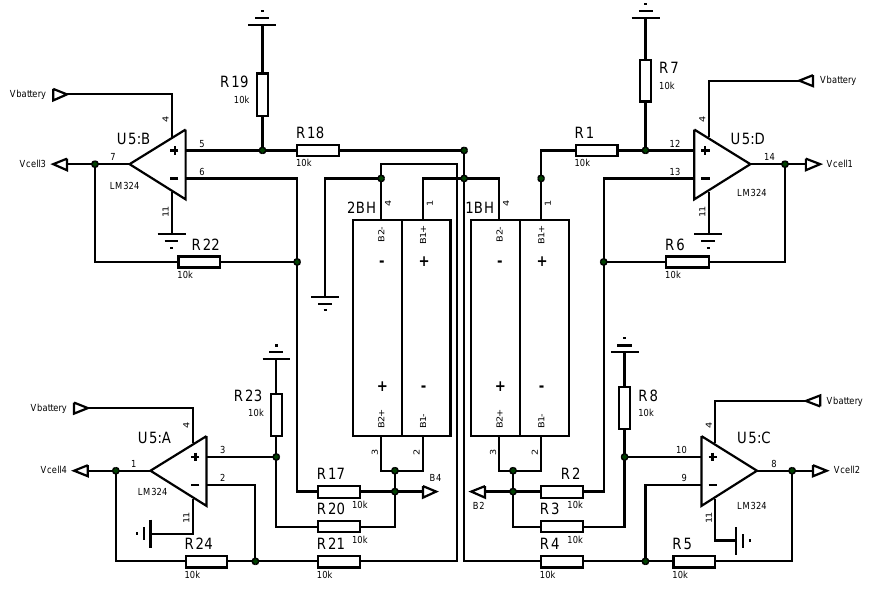
Figure 3. Electronic circuit diagram of the voltage measurements The power distribution and regulation is considered to be the most important con- straint to address in embedded systems [28]. Figure 4 shows the electronic scheme for the power regulation, current measurement and energy